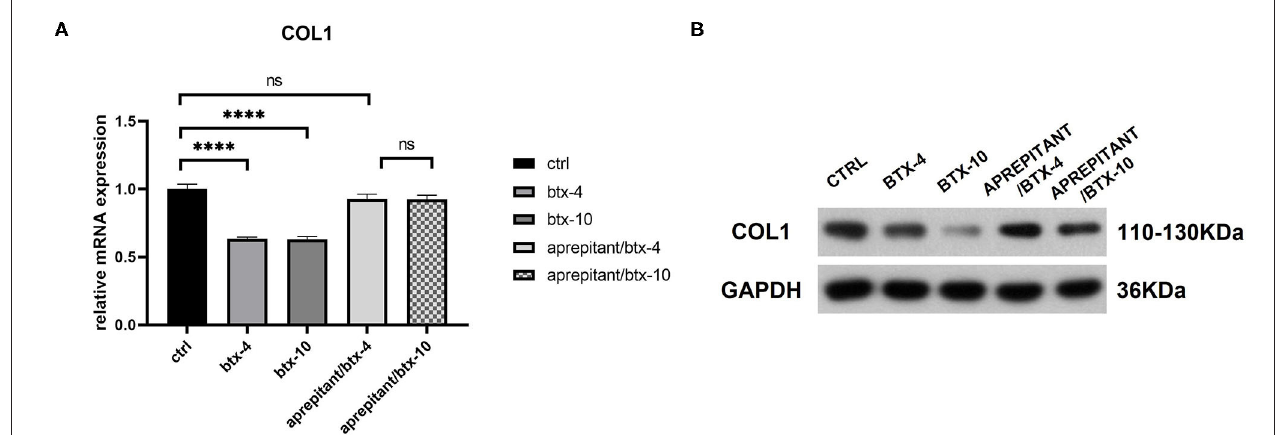
FIGURE 6 | The mRNA and protein expressions were from hypertrophic scar-derived fibroblasts treated with BTX-A (4 or 10 U/mL) and NK-1R antagonist aprepitant (5 µ M). (A) Relative mRNA expression of type 1 collagen after treatment with BTX-A in the presence or absence of aprepitant; (B) Expression of type 1 collagen after same BTX-A and aprepitant treatment detected by western blot analysis. The results are represented as the mean of 3 experiments ± SD, which were performed in duplicate for each experimental condition (ns P ≥ 0.05; **** P < 0.0001).